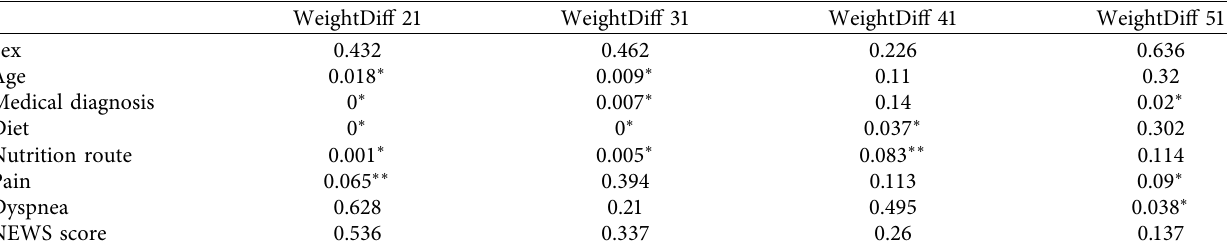
Table 3: Significant probability ( p value) of patients’ weight difference (WeightDiff) according to risk factors or